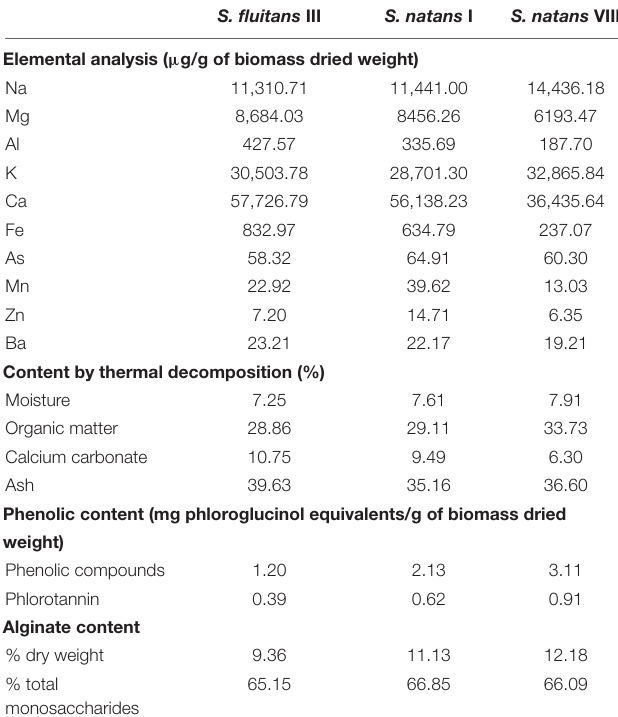
TABLE 3 | Chemical composition of the different Sargassum species (Davis et al.,